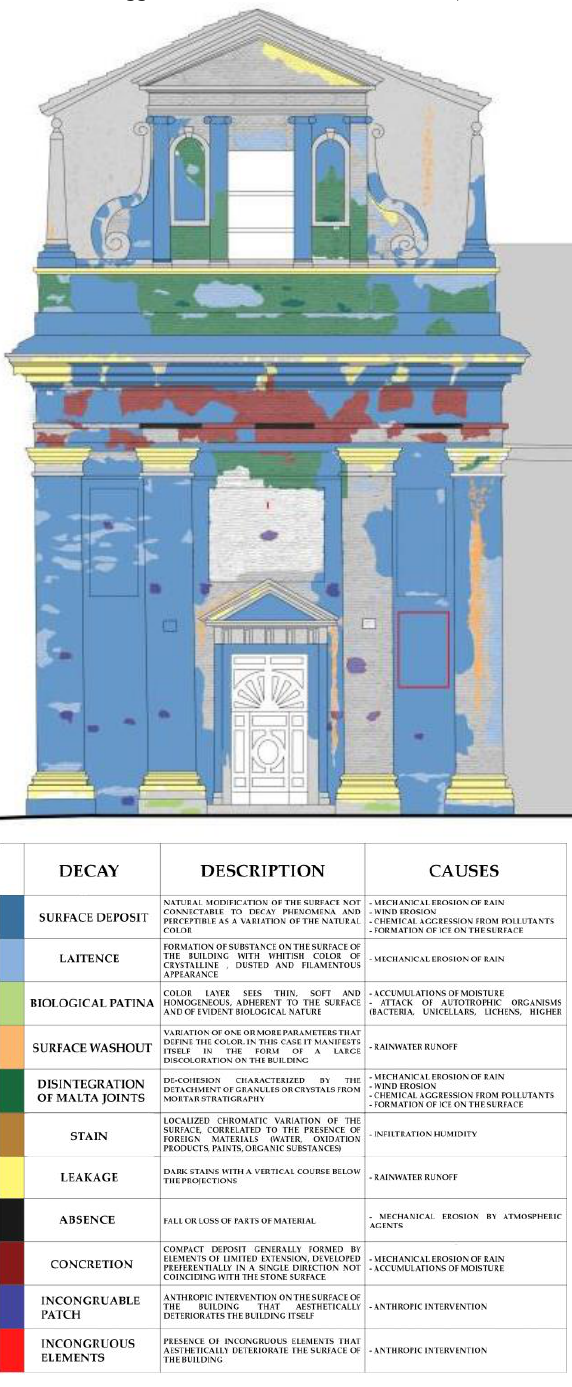
Figure 6. Main façade: thematic map of the material decay and related descriptive legend (Onori